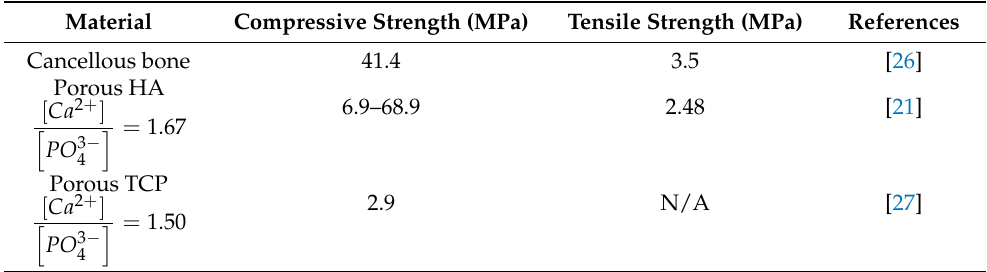
Table 1. Comparison between synthetic CaP and bone mechanical properties.